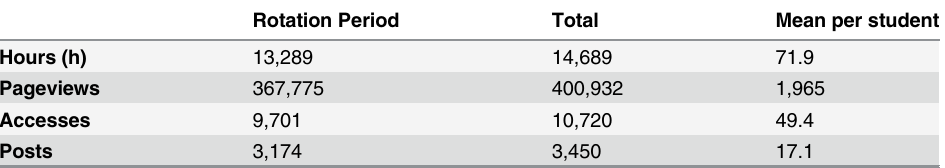
Table 2. Student participation at the emergency VLE